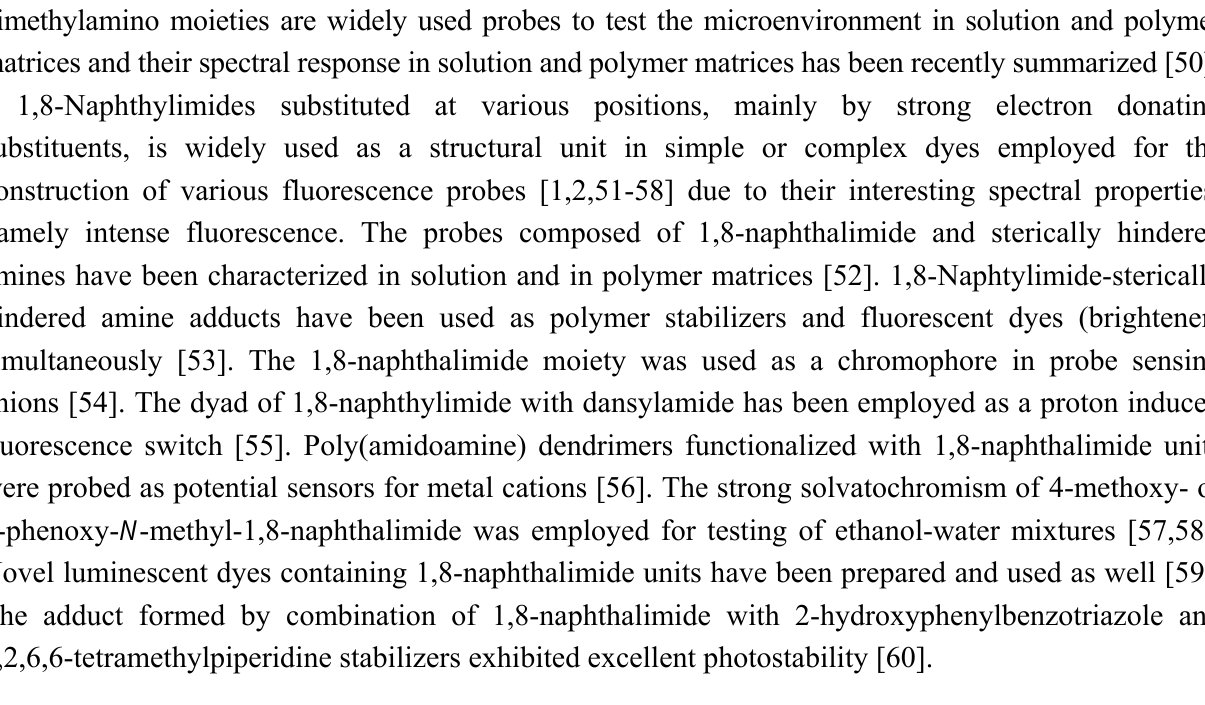
Figure 1. Structures of the bichromophoric coumarins and model